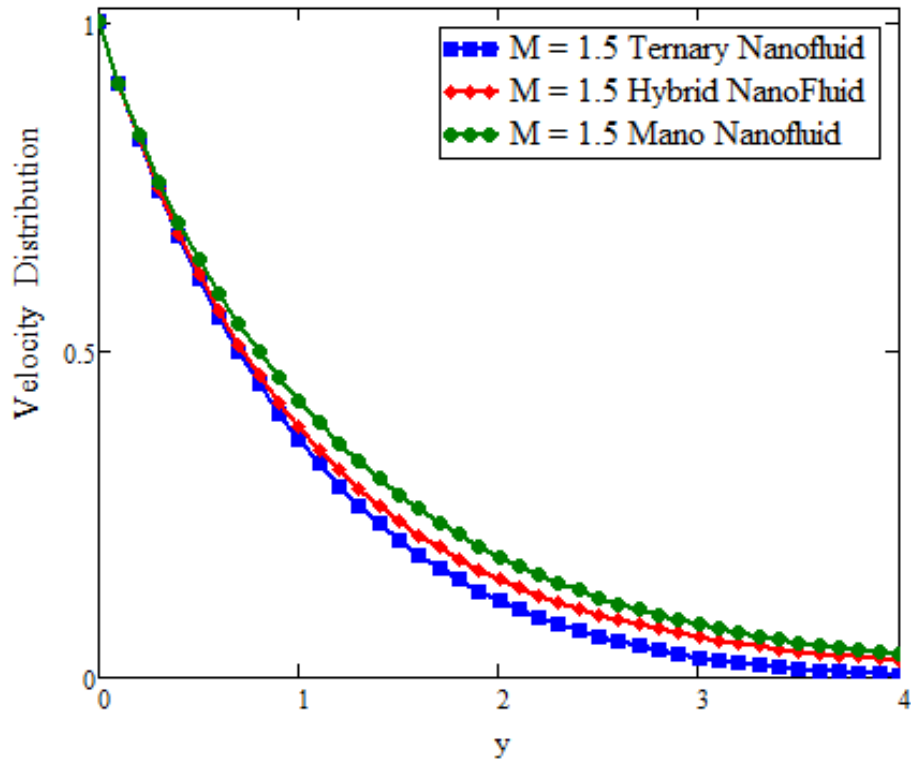
Figure 9. Comparison of velocity assessment with magnetic parameter M across y as α = 0.3, β = 0.3, γ = 0.3 when t = 1, φ 1 = 0.03, φ 2 = 0.03, φ 3 = 0.03 Pr = 21, Gm = 1.4, and Gr =